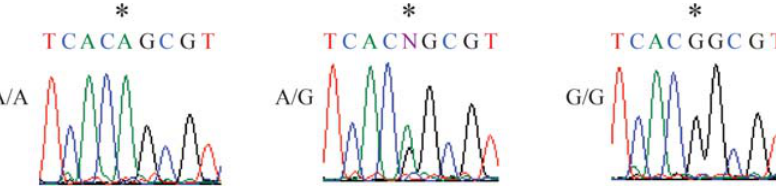
Figure 3 - A polymorphism of p16 INK4a at position -191. Genomic DNA was amplified by PCR with a forward primer at positions -485 to -465 and a re- verseprimerat+214to+194ofthe p16 INK4a gene,andnucleotidesequencesweredeterminedbydirectlysequencingthePCRproducts.Thesesequencing reactions were performed using a primer at positions -248 to -228. (*) shows nucleotides at position -191 in the p16 INK4a promoters, where “N” indicates heterozygous nucleotides. Nucleotides around the polymorphic position (*) are